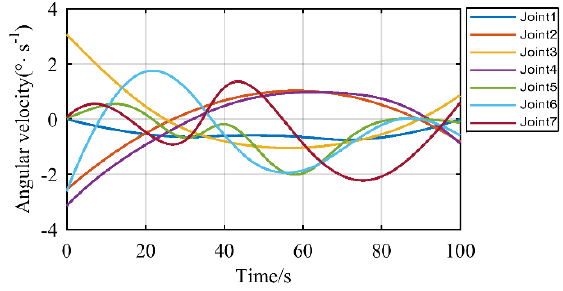
Figure 16. Angular velocity of each joint.